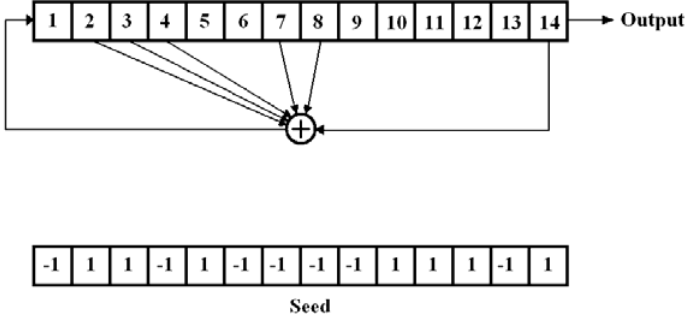
Figure 5. Maximum length sequence generator from which the PRN interfering signal used in this work is obtained. PRN interfering signal is composed by the repetition of the first 10,230 output